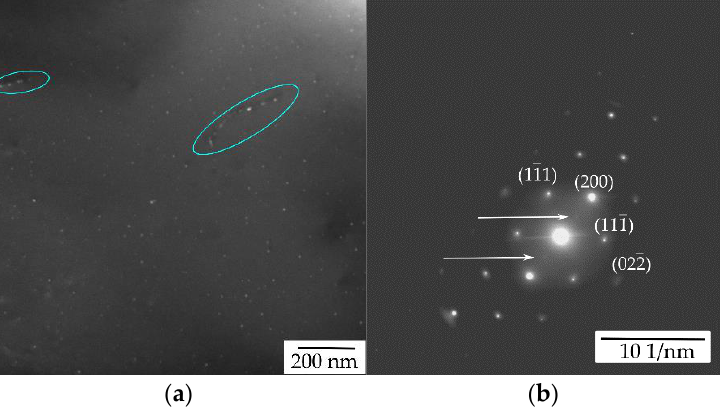
Figure 13. TEM image of the AlYb HT alloy after isochronal treatment up to 330 °C — see ( a ) secondary Al 3 Yb particles, some of them precipitated along dislocations and ( b ) selected area diffraction near [011] Al pole with spots from the L1 2 structure.